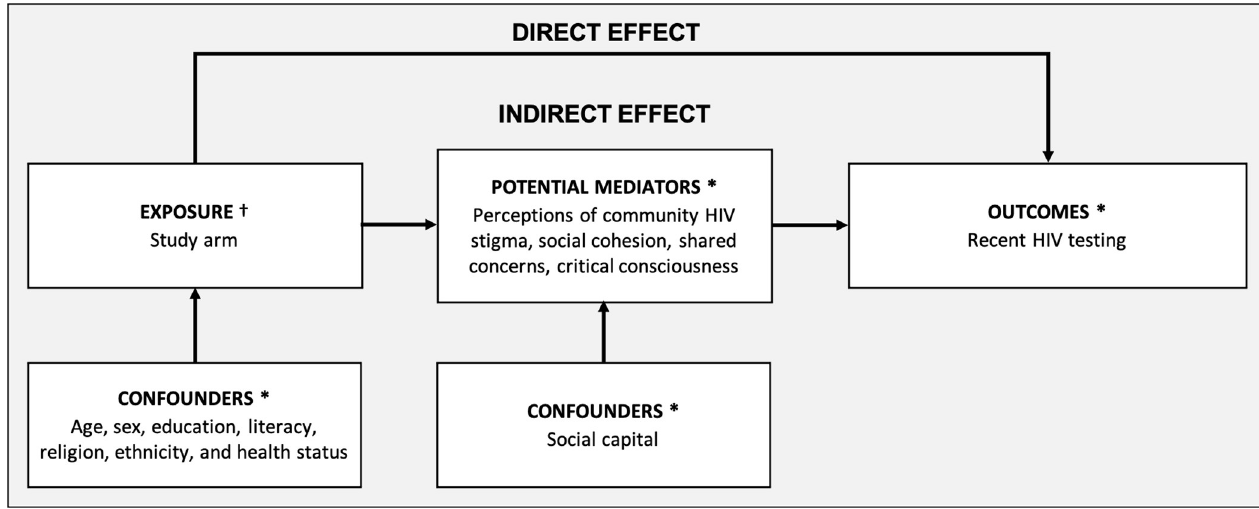
Fig 1. Diagram of mediation framework. HIVST, HIV self-testing. Causal directed acrylic graph of the mediation framework. � Measured at the individual level. † Measured at the cluster level.